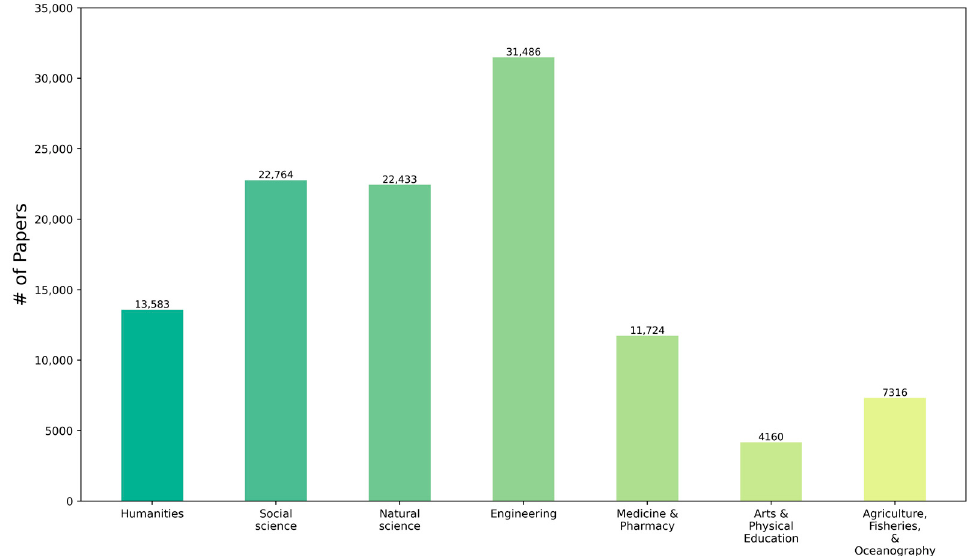
Figure 4. Expert datasets retention status by domain.